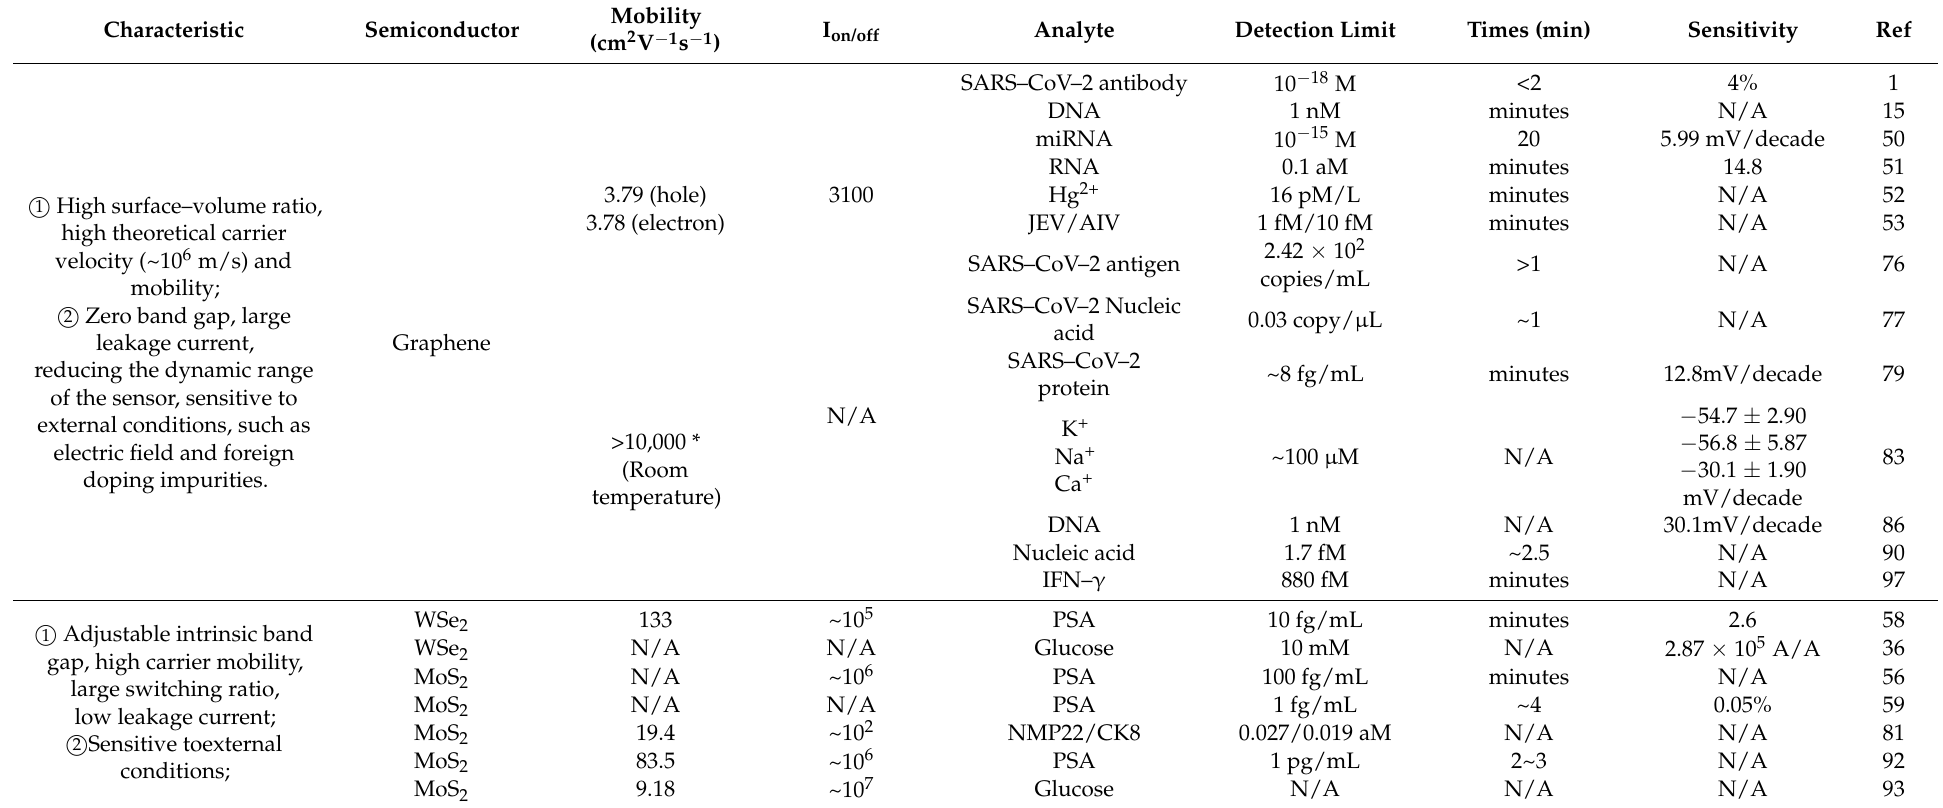
Table 1. Semiconductor materials used for FET